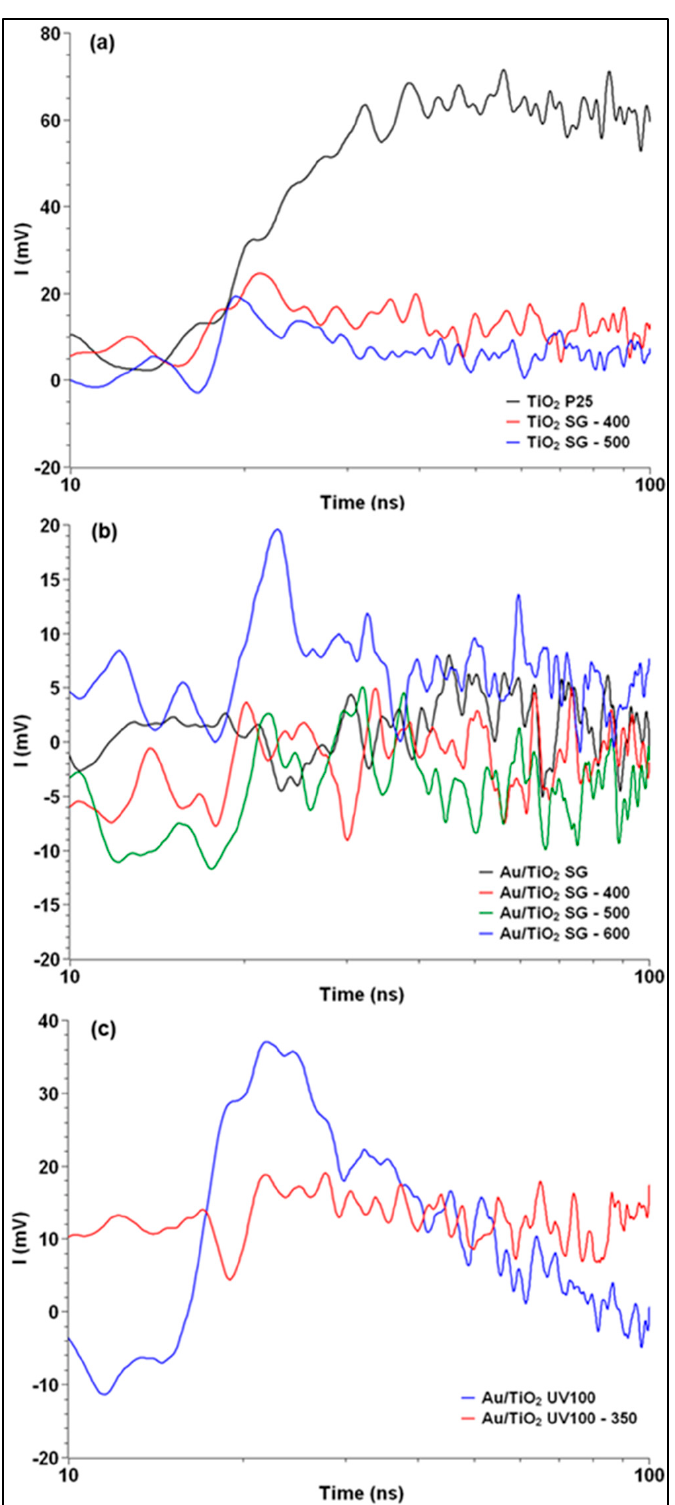
Figure 7. TRMC signals at 360 nm obtained on ( a ) TiO 2 P25, TiO 2 SG-400 and TiO 2 SG-500 supports ( b ) Au/TiO 2 SG-X and (c) and Au/TiO 2 UV100-350 commercial-based samples.